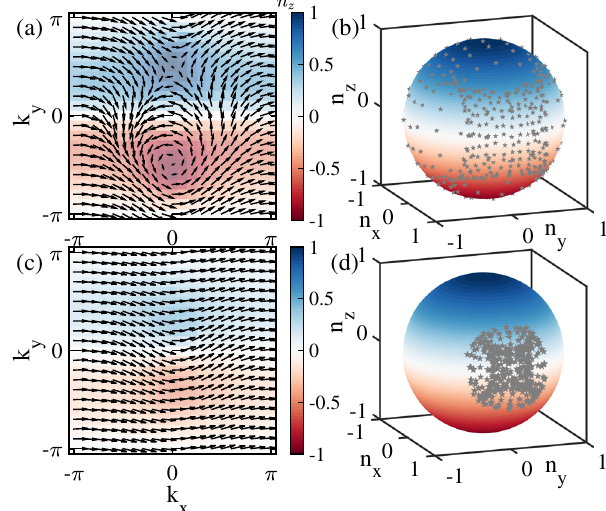
Fig. 2 Measurements of the Euler class. a The experimentally measured vectors n ( k ) for the Euler Hamiltonian H ( k ) in Eq. (1) with m = 1 (corresponding to a nontrivial Hamiltonian) over a 20 × 20 discretized Brillouin zone and b their distribution on the sphere S 2 . c The experimentally measured vectors n ( k ) for the Euler Hamiltonian H ( k ) in Eq. (1) with m = 3 (corresponding to a trivial Hamiltonian) over a 20 × 20 discretized Brillouin zone and d their distribution on the sphere S 2 . In the nontrivial case, the vectors n ( k ) exhibit a nontrivial skyrmion structure and cover the entire sphere once, yielding a nonzero Euler class ξ = 2, whereas in the trivial case, the vectors cover parts of the sphere, yielding a zero Euler